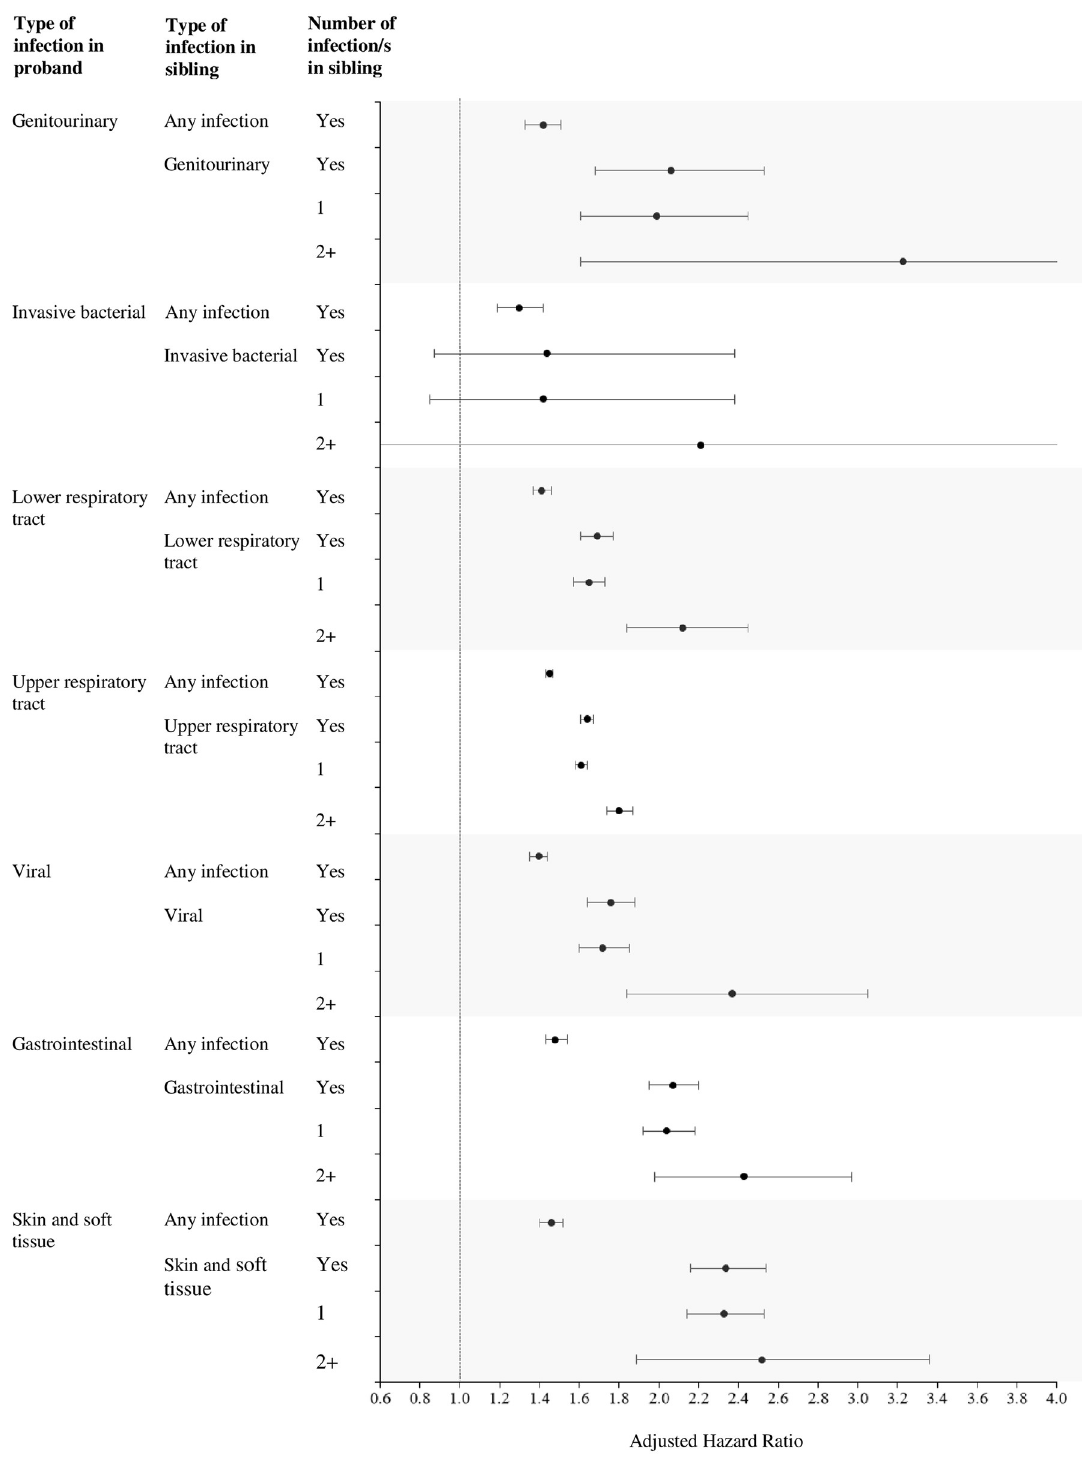
Fig 3. Infection-related hospitalization sibling hazard ratios by clinical infection groups. Infection-related hospitalization sibling hazard ratios by type of clinical infection in proband (outcome) and sibling (exposure), compared to risk in probands whose sibling/s did not have infection-related hospitalizations (reference group). Adjusted for maternal age, parity, gestational age, birth weight, sex of the child, season of birth, 5-minute Apgar score, birth mode, birth year. Number of infections in sibling was analyzed as both dichotomous (Yes/No (reference)) and categorical (0 (reference), 1, 2+).